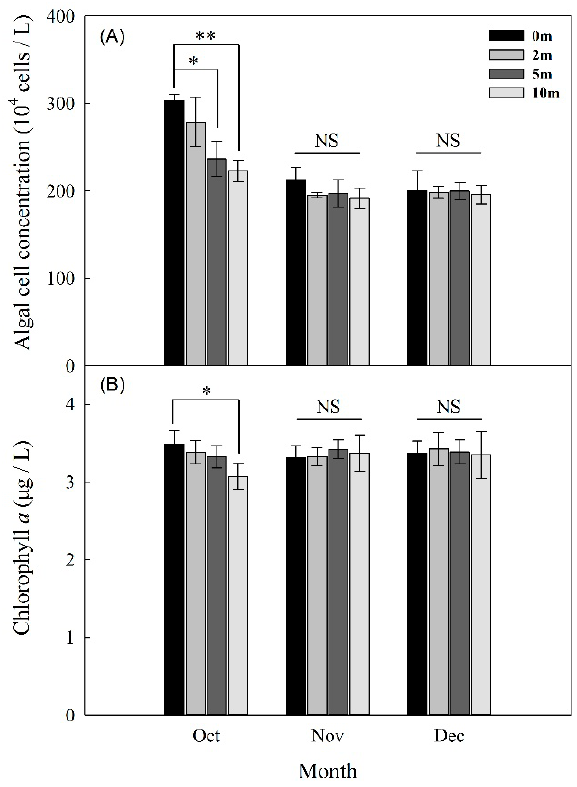
Figure 2. Algal cell ( A ) and chlorophyll a concentrations ( B ) in Jinpen reservoir from October to December, 2018, the data for each month are the means of all stations and the error bars represent the standard deviations ( n = 3). * p < 0.05, ** p < 0.01.